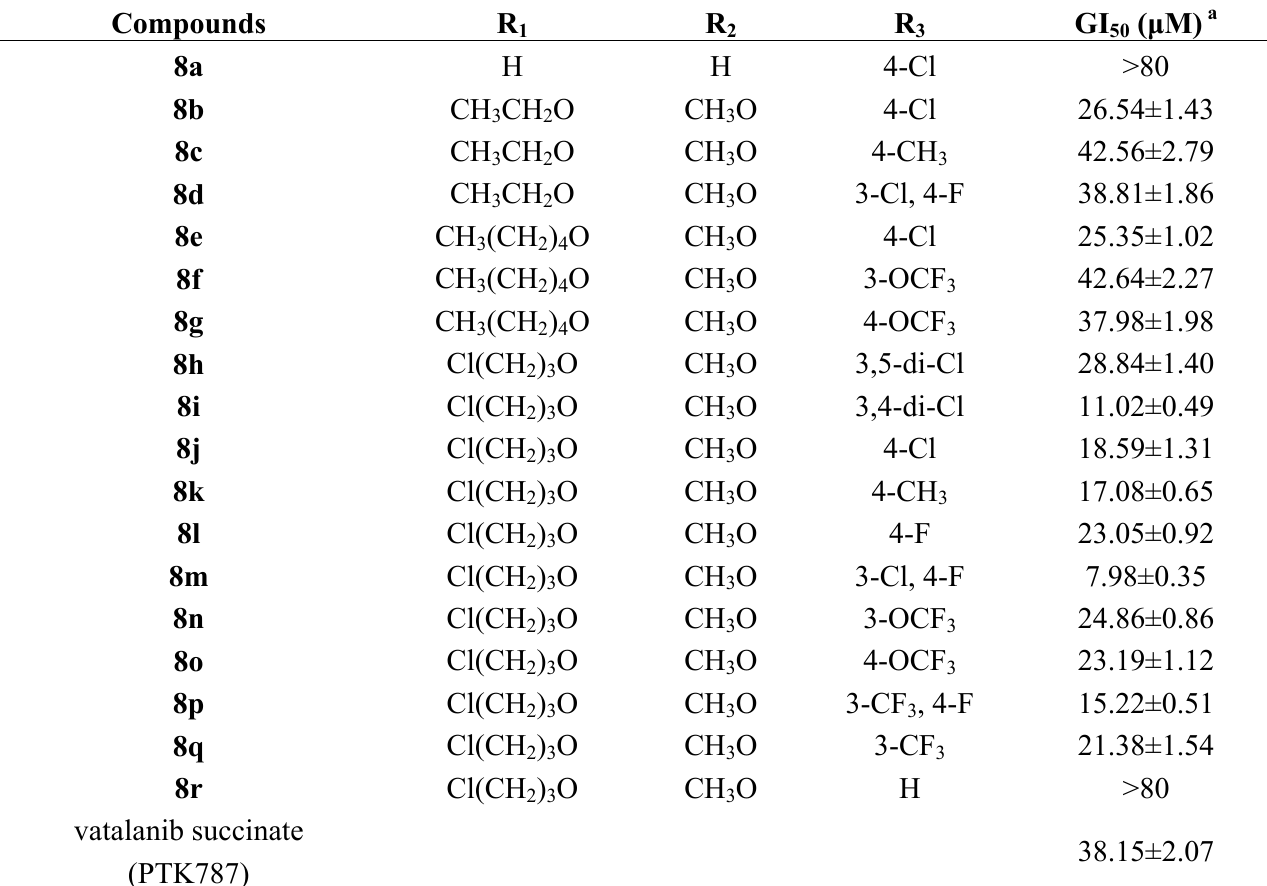
Table 1 . The structures of target compounds and their antiproliferative effects in